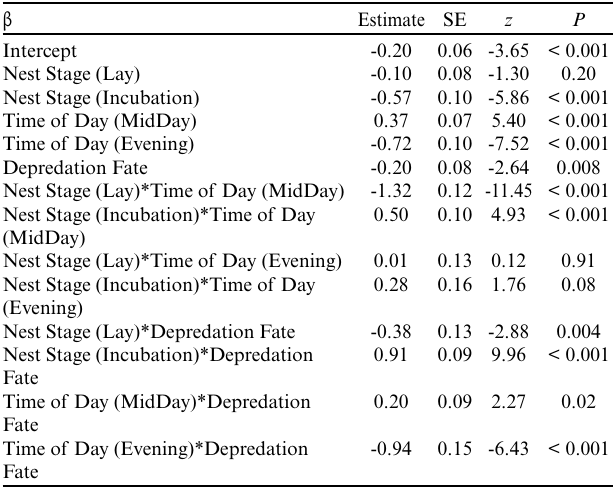
Table 4. Parameter estimates for the best model assessing the predator-attraction hypothesis and the relationship between vocalization rate by male vireos and nest stage (Stage), time of day (Time), and depredation fate (Depr).